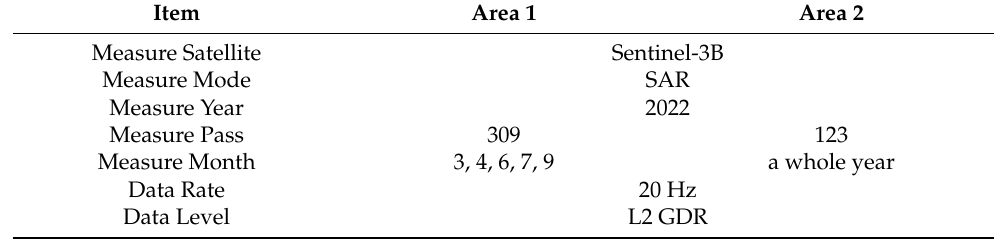
Table 1. Dataset information for experimental areas used for coastal waveform processing.